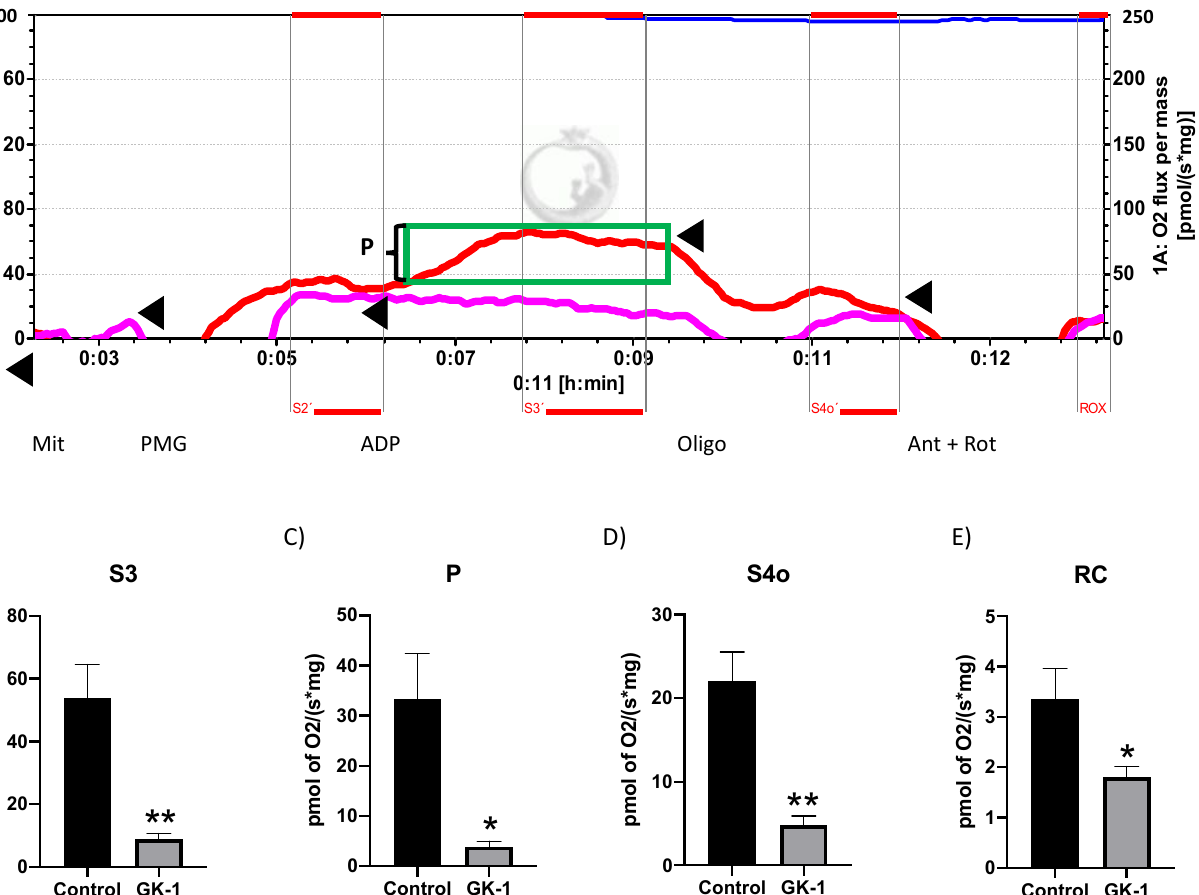
Figure 5. GK-1 inhibits cellular respiration and induces mitochondrial uncoupling in breast tumors. Mitochondrial respiratory parameters: ( A ) Representative tracings comparing experimental groups control vs. GK-1. We added the different substrates to the O2k FluoRespirometer chamber in the following sequence: mitochondria (Mit), pyruvate–malate–glutamate (PMG), adenosine phosphate (ADP), oligomycin (Oligo), and antimycin + rotenone (Ant + Rot). ( B ) ADP-stimulated respiration (state 3; S3), ( C ) Oxidative phosphorylation (OXPHOS)-linked-respiration (P), ( D ) State 4 was induced by 5 µM oligomycin (S4o), and ( E ) respiratory control (RC). State 2 (S2) corresponds to the oxygen consumption in presence of mitochondria plus PMG (CI-linked substrates). S3 corresponds to mitochondria oxygen consumption that was stimulated by the addition of 2.5 mM adenosine diphosphate (ADP). RC corresponds to the S3/S4o ratio. P was calculated by the formula: S3-S4o. All the parameters were corrected by subtracting the non-mitochondrial respiration (ROX). t - Student test, control vs. GK-1, * p < 0.05; ** p < 0.005. Data are expressed as mean ± SEM, n = 5. The red line indicates solution saline isotonic treatment (control), and the pink line indicates GK-1 treatment. The addition of the different substrates is indicated by triangles.